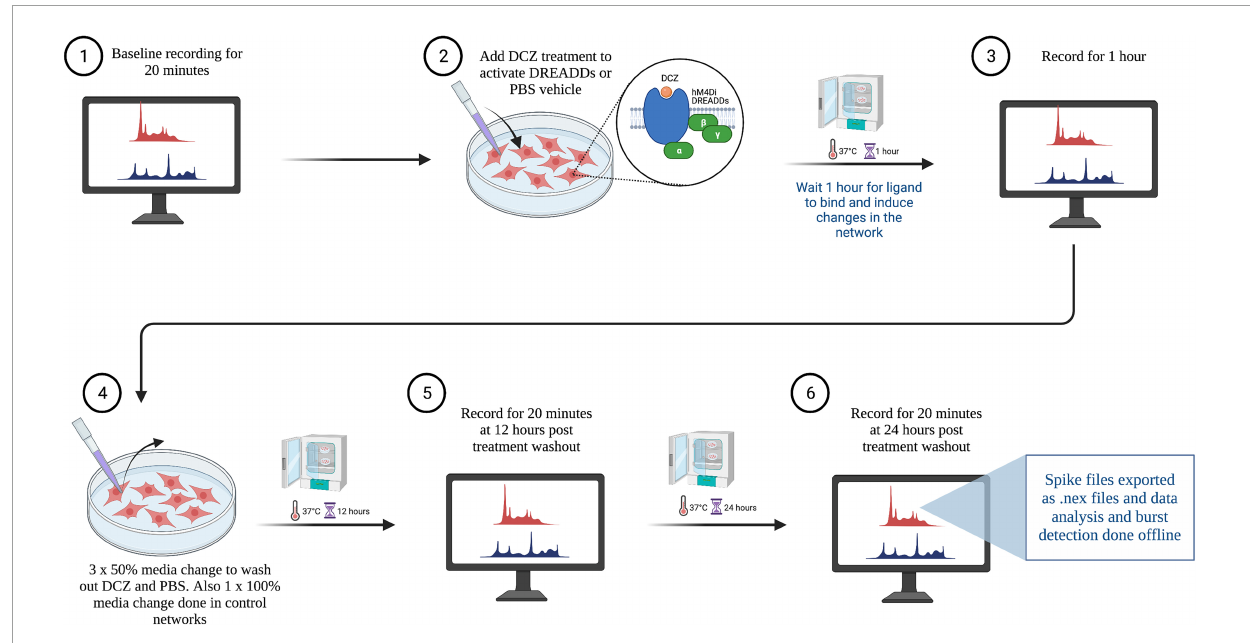
FIGURE2 Workflow of electrophysiological recordings with treatment and wash out steps. Created with BioRender.com.